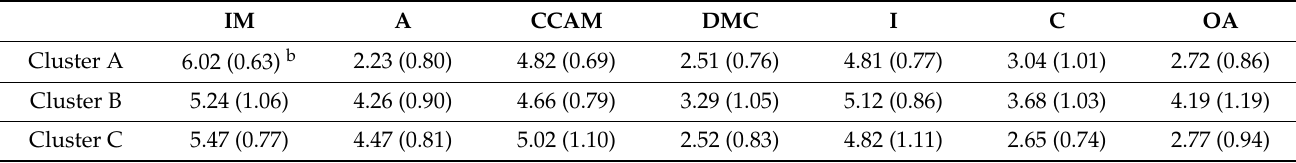
Table 2. Descriptive statistics of scores on scales by cluster.